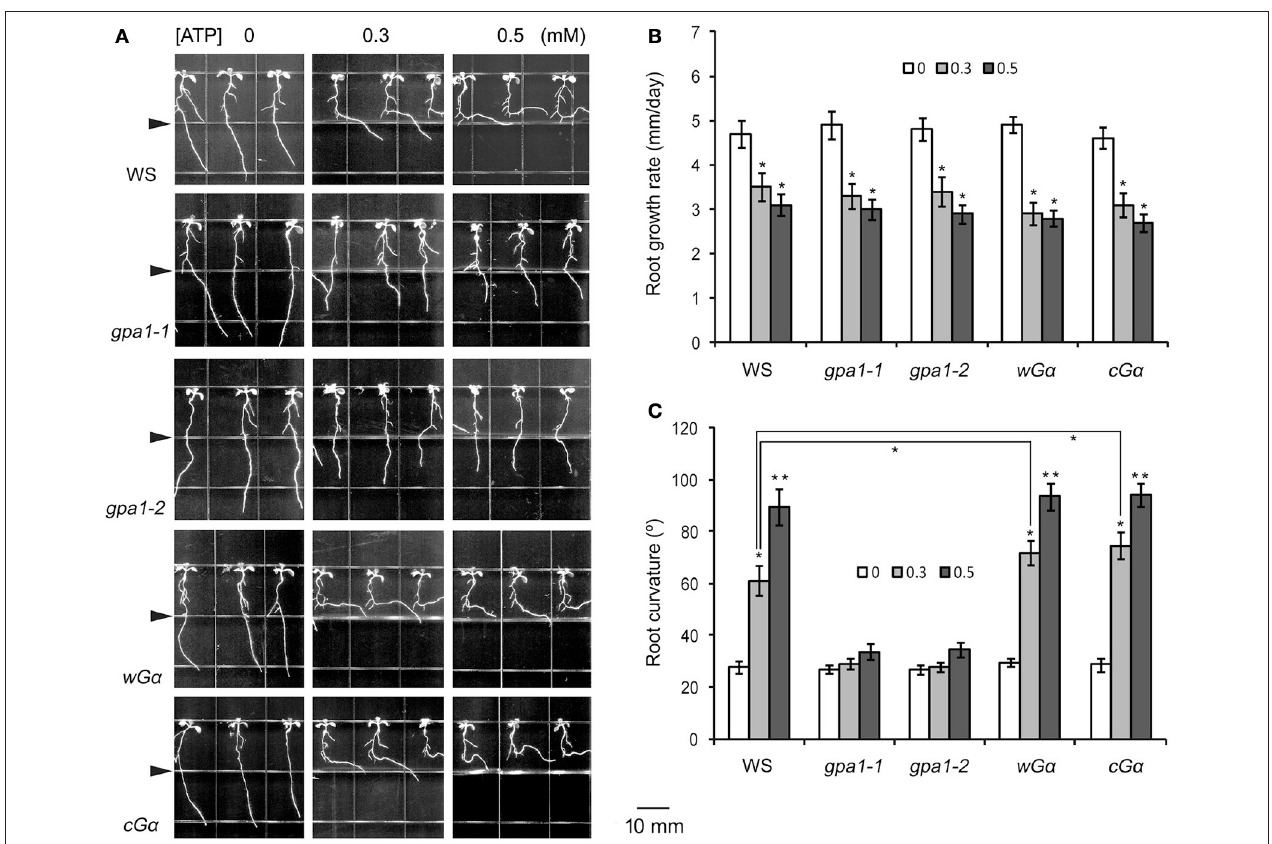
FIGURE 2 | Heterotrimeric G α is involved in eATP avoidance response. (A) Seedlings of WS, G α null mutants ( gpa1-1 , gpa1-2 ) and OE lines ( wG α and cG α ) grown in jointed medium containing 0, 0.3, and 0.5 mM ATP in the lower part, respectively. Note the different response of various genotypes to ATP. Seedlings were photographed 5 days after transplantation. In each photo series, the triangle marks the joint line of the two media. The scale bar is showed beside. (B,C) note the effect of ATP on root growth rate (B) and root curvature (C) , respectively. In each experiment, root growth rate and curvature of at least 30 seedlings were measured, and data from 3 replicates were calculated to get the mean ± SD. Student’s t -test p -values: * p < 0.05, ** p <